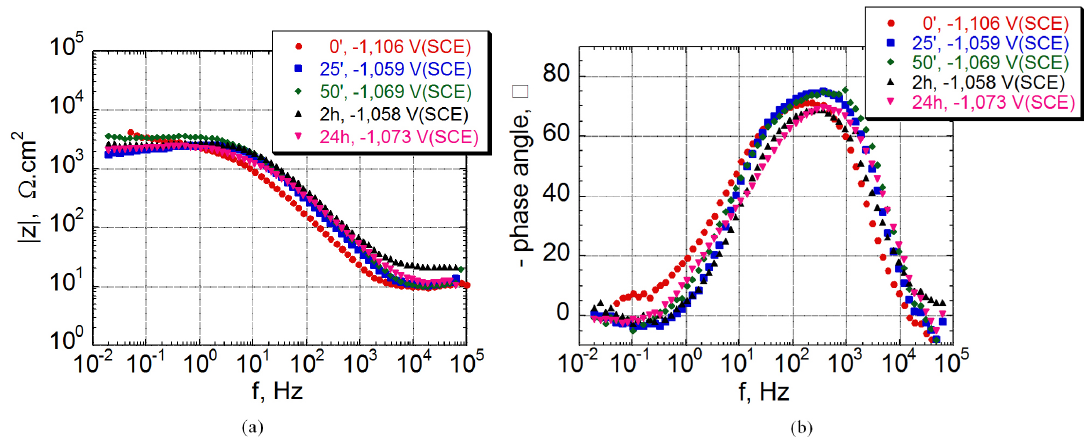
SO , pH 10, solution, 2 4